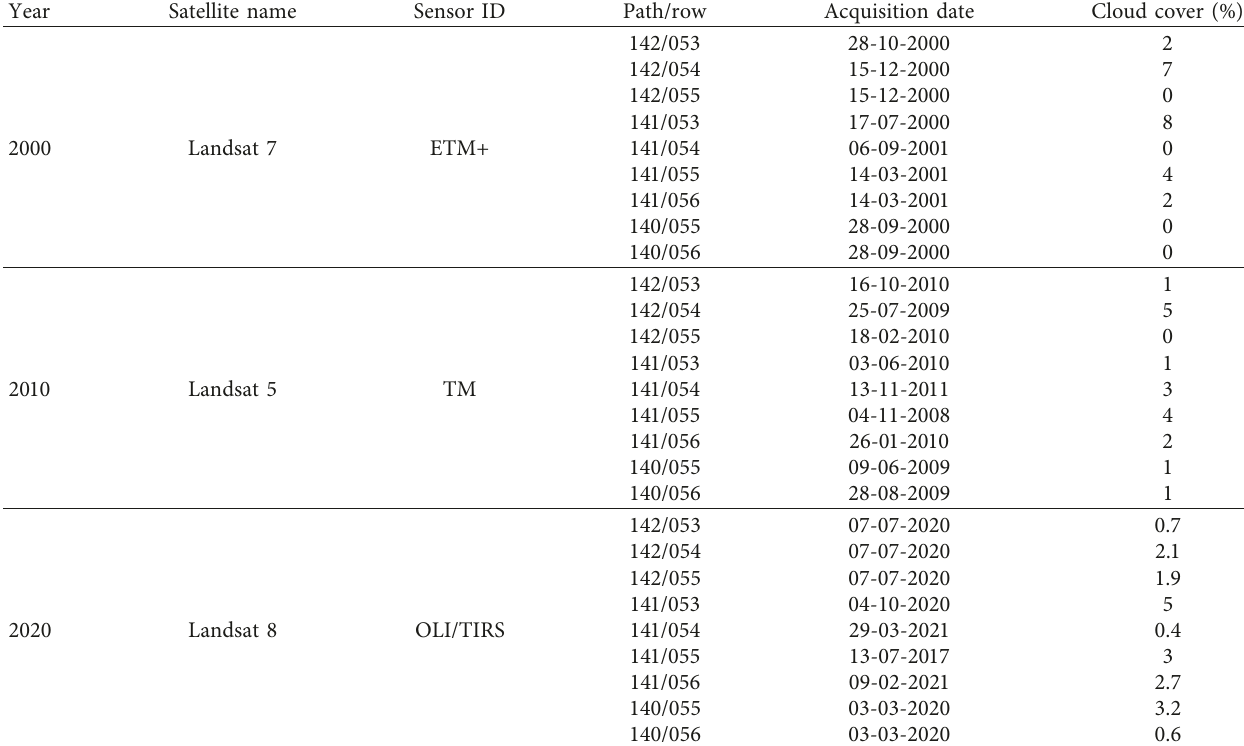
Table 1: Dataset information on sensors and bands.